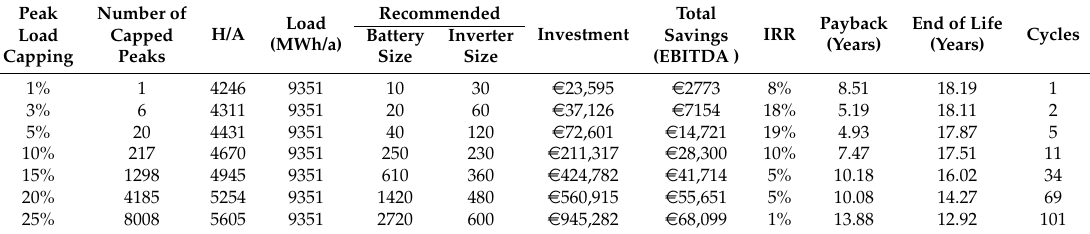
Table 7. Profile A wich peak load capping variating from 1% to